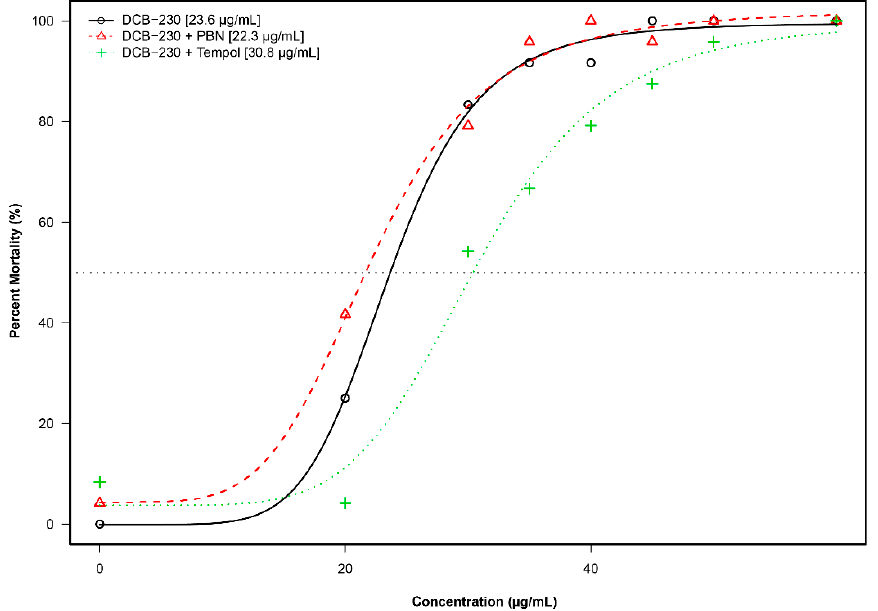
Figure 6. Incidence of overt toxicity responses to DCB-230 and antioxidants at 120 hpf. The modeling of the data illustrates that DCB-230 alone (black) and DCB-230 + PBN (red) had similar EC50s while DCB-230 + TEMPOL (green) was distinctly different.